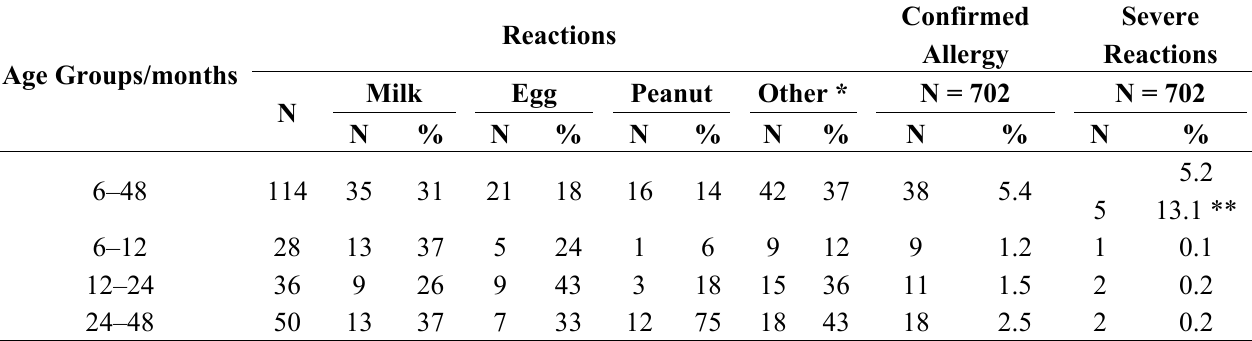
Table 1. Prevalence of reactions according to the sort of food and age, confirmed allergy and severe reactions.